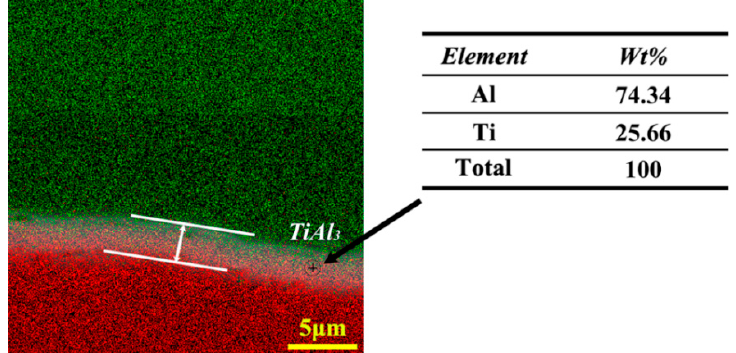
Figure 4. The element face scan in the bonding interface of LMCs di ff used at 550 ◦ C and the percentage of two elements at di ff usion